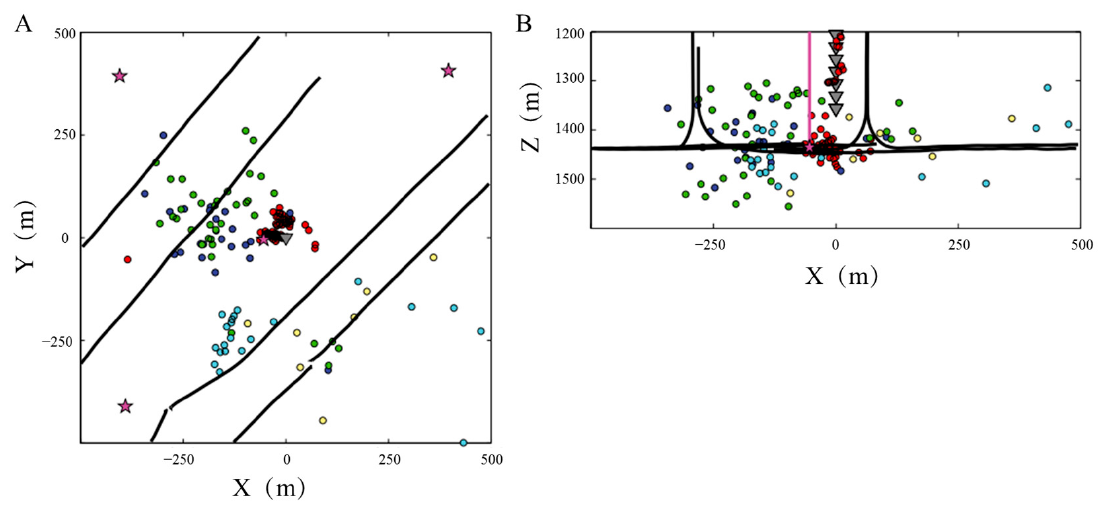
Figure 4. Microseismic events cloud distribution during project operation (modified from Verdon J P et al., 2013 [29]. ( A ) is the XY view of the monitoring area. ( B ) is the XZ view of the monitoring area. The pentagram are injection wells. The triangle is the monitoring well. Events are colored by occurrence time: yellow dots are before CO 2 injection, dark blue dots are during the initial injection stages, green dots during a period of elevated injection in summer 2004, light blue dots are during the second phase of monitoring in 2005–2006, and red dots are after injection well shut in September 2010).